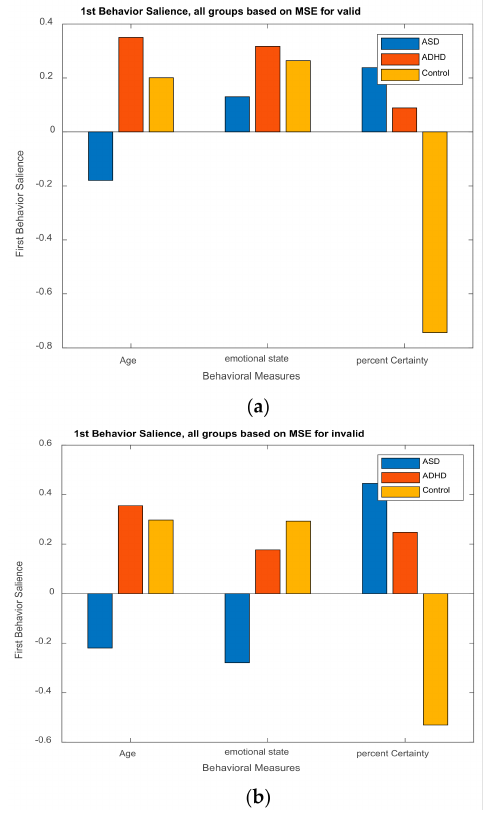
Figure 14. ( a ) 1st behavior salience, valid syllogism. The 1st behavior salience reveals the difference ASD and the other groups for age (‘maturation effect’) and the difference between control